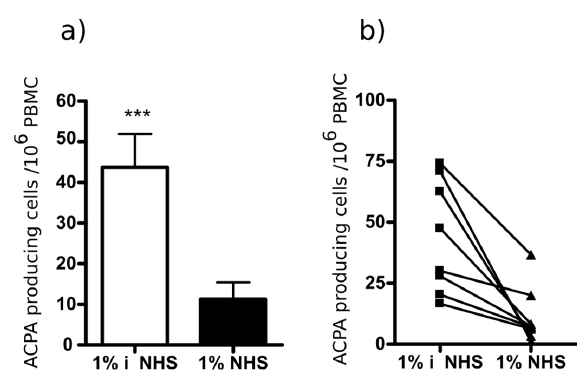
Figure 8. Ex vivo inhibition of the Cit-peptide-specific antibody production by bifunctional